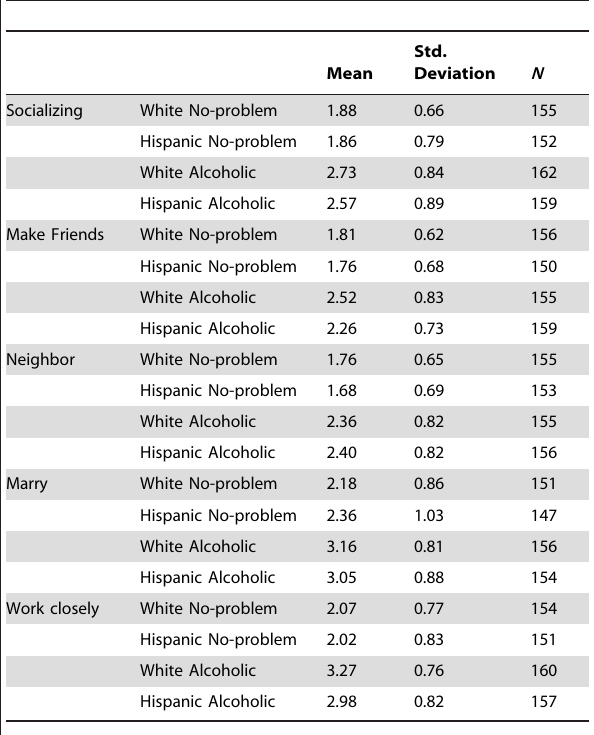
Table 2. Summary Statistics for Social Distance.